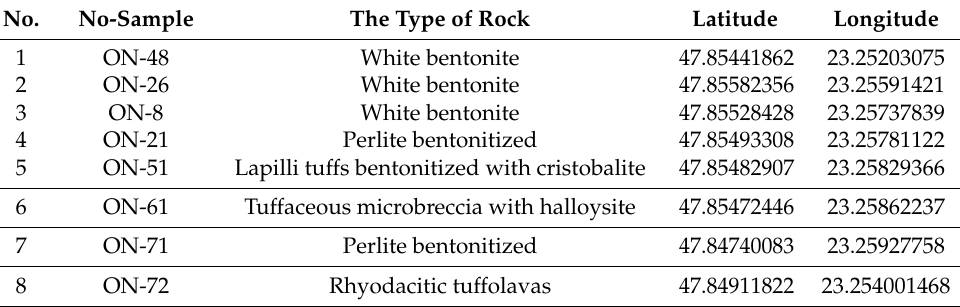
Figure 2. Position of the sampling points Ora ş u Nou area represented using a Google Maps base map [39]. Table 1. Location and details of the representative bentonite and bentonitized rock